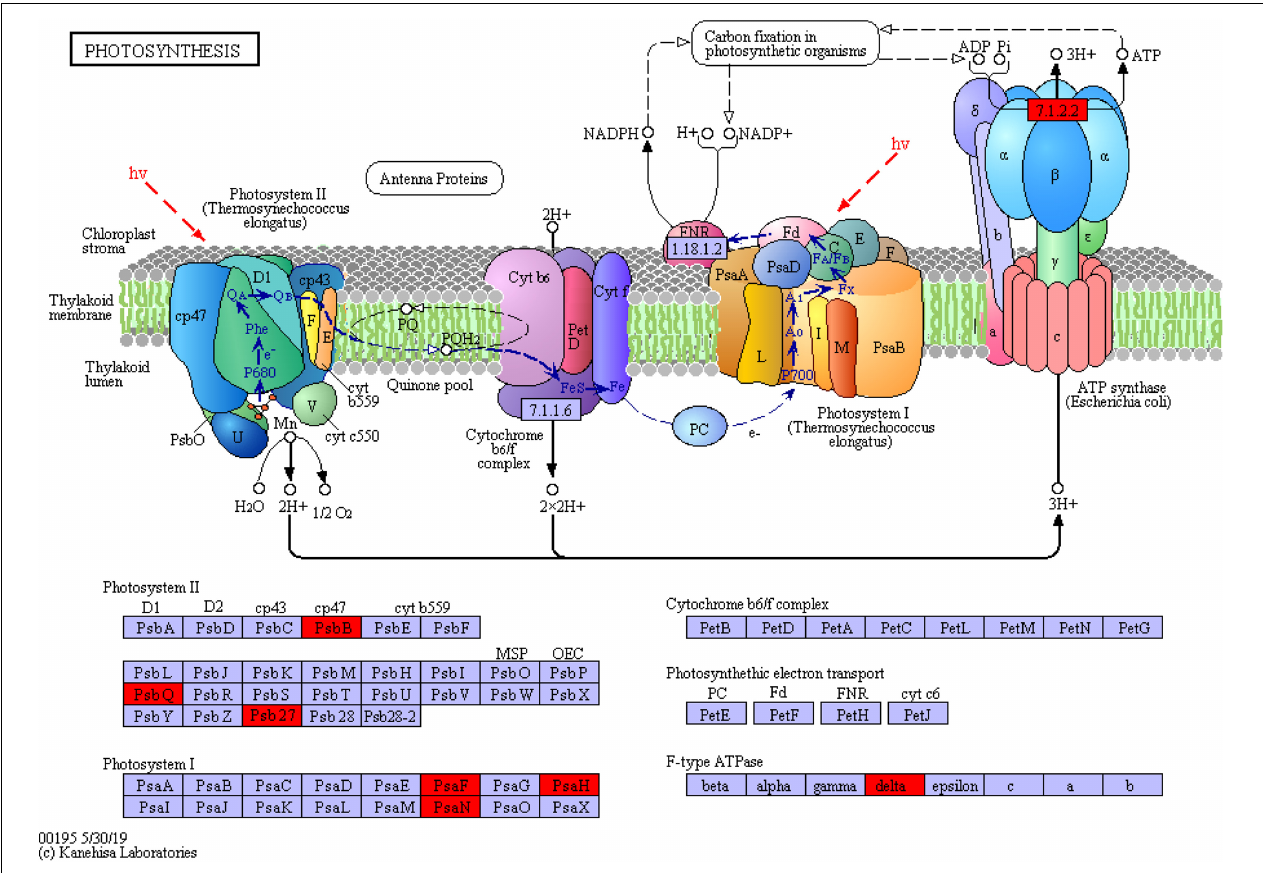
FIGURE 10 | Photosynthetic protein synthesis pathway and differential protein expression. The red box represents the upregulated